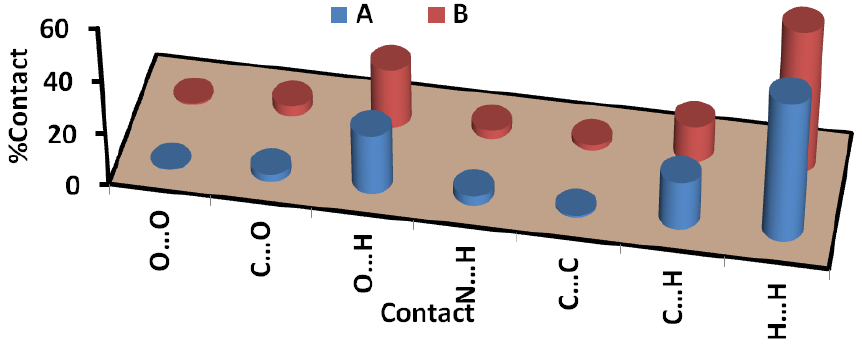
Figure 4. Hirshfeld surfaces of 4 . Molecule B has letter B in atom numbering, while A does not.